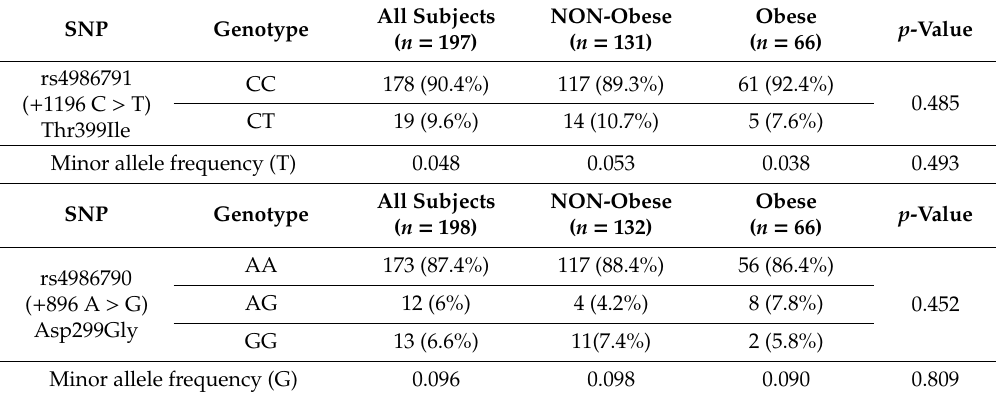
Table 2. Genotype distribution and minor allele frequency in non-obese group versus obese group.